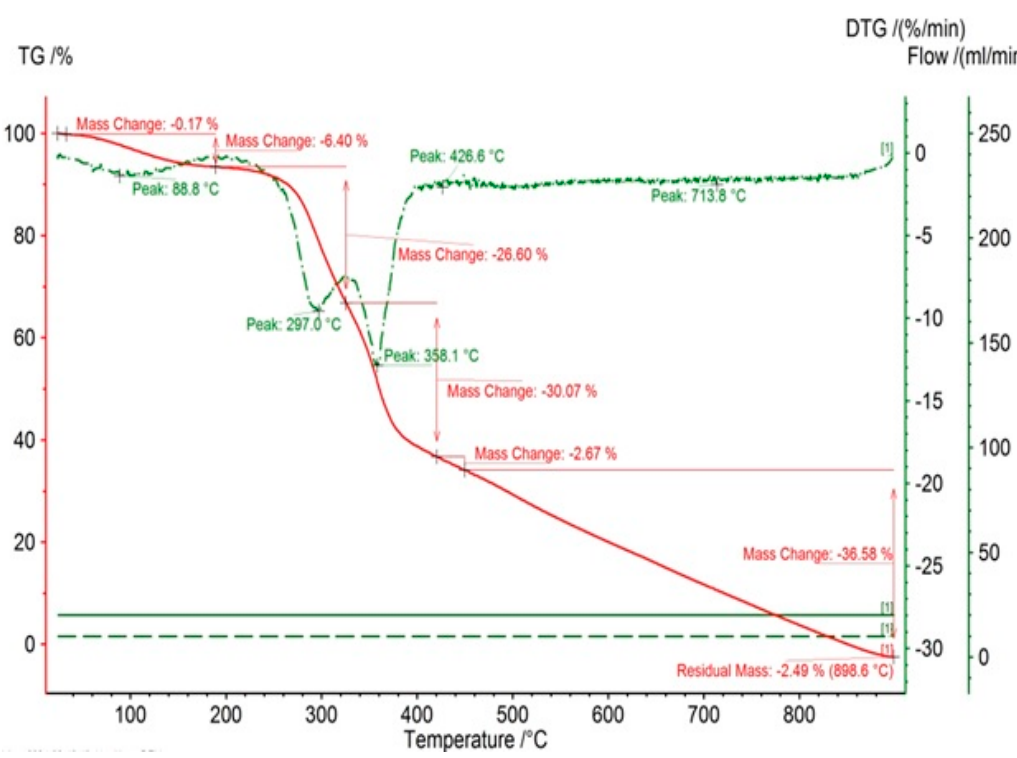
Figure 4. TGA response curve for biomass presenting change of mass and DGT.